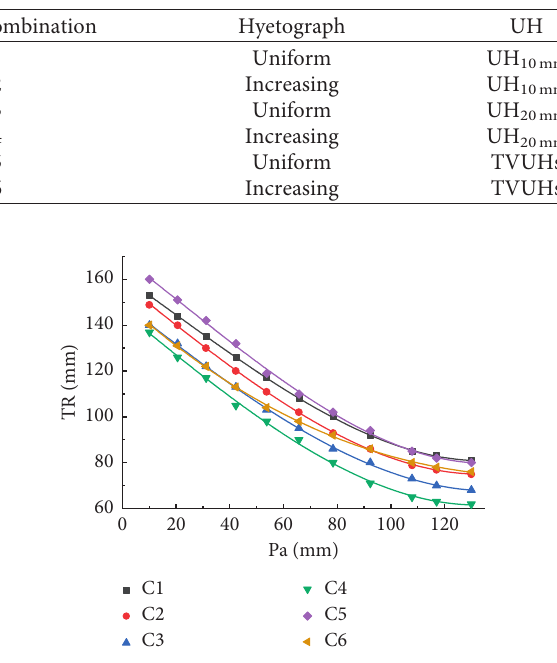
Figure 11: CR-Pa curves of six combinations of UHs and hyetographs.